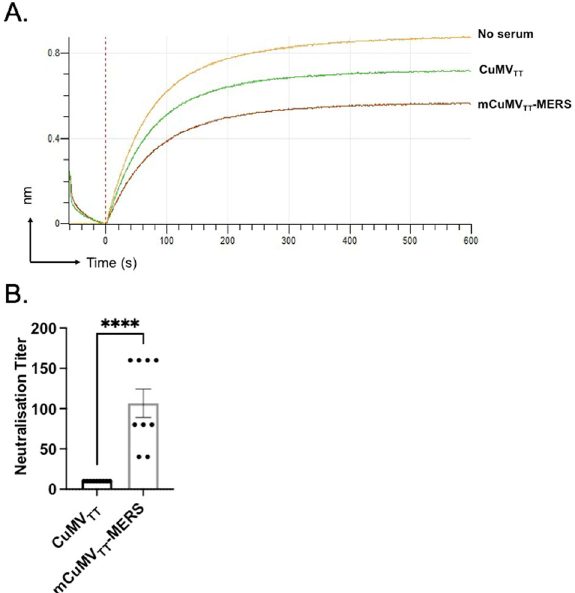
Fig. 6 mCuMV TT -MERS blocks binding to RBD to the viral receptor DPP4 and neutralizes wild-type MERS virus. a BLI-evaluation of DPP4 binding to RBD in the presence of vaccinated mice sera. Binding of DPP4 to BLI biosensors coated with RBD-his tag is signi fi cantly reduced in the presence of mouse sera (1:10 dilution, d35) after 2nd vaccination with mCuMV TT -MERS (brown line) than with CuMV TT control (green line) or with no serum (line orange) consistent with DPP4-blocking activity. b Neutralization titers (CPE) of the groups vaccinated with CuMV TT control and mCuMV TT -MERS, p < 0.0001. Statistical analysis using Student ’ s t test. Control group n = 10 and vaccine group n = 9 . One representative of two similar experiments is shown. The value of p < 0.05 was considered statistically signi fi cant (* p < 0.01, ** p < 0.001, *** p <